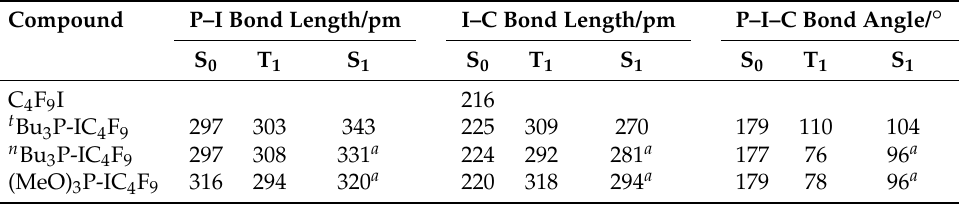
Figure 3. Calculated absorption spectra of t Bu 3 P in DCM (black: continuum solvent model, red: t Bu 3 P-DCM adduct surrounded by a continuum solvent model of DCM) and frontier molecular orbitals of the t Bu 3 P-DCM monoadduct. Table 1. Selected geometry parameters of perfluorobutyl iodide and its phosphine and phosphite adducts in the electronic ground state (S 0 ), the first excited triplet (T 1 ), and singlet (S 1 ) state.